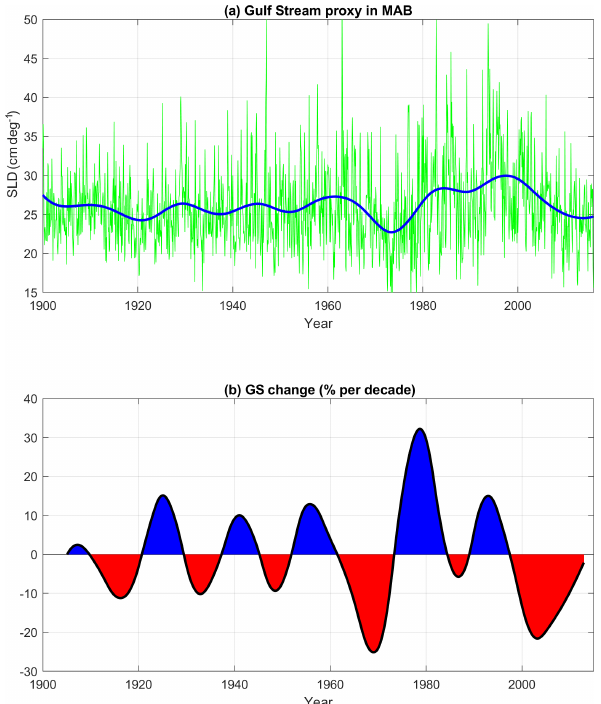
Figure 9. (a) Gulf Stream proxy in the Mid-Atlantic Bight (GS- MAB) calculated from the average change in sea level across the GS; the units are centimeter change per 1 ◦ latitude. The green line is for monthly values, and the heavy blue line is the sum of low- frequency EMD modes. (b) The change in the strength of the GS of the low-frequency modes in (a) ; the units are percentage change per decade, with red and blue representing periods of weakening and strengthening of the GS